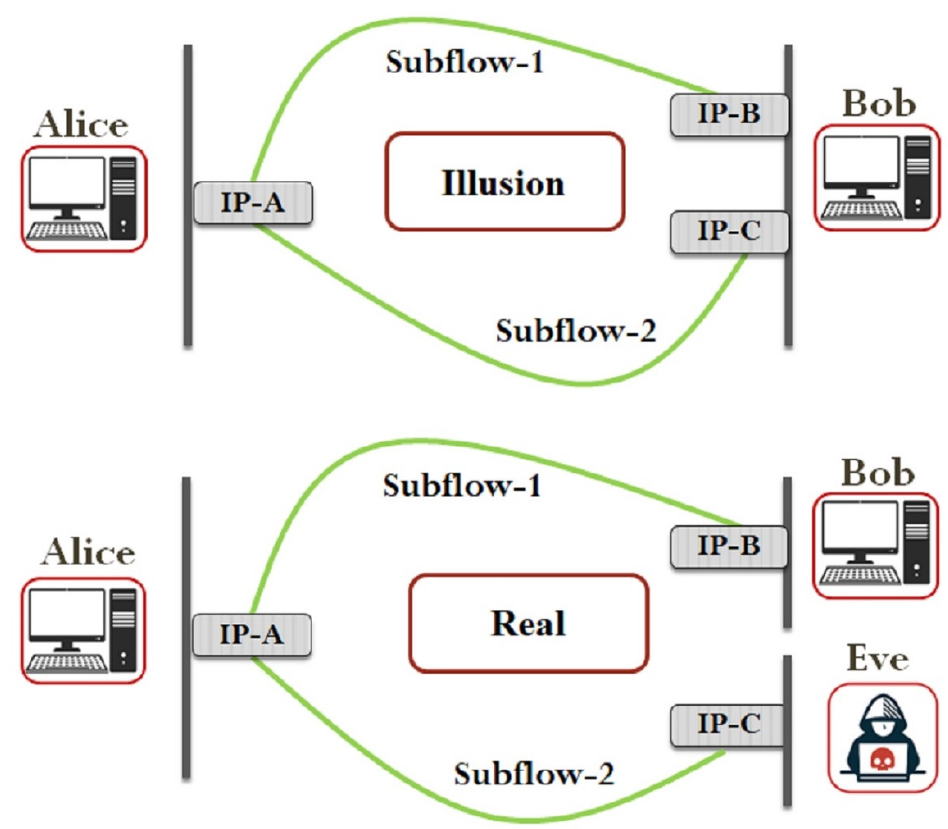
Figure 8. Real vs. illusion for Alice and Bob during the session hijacking attack.